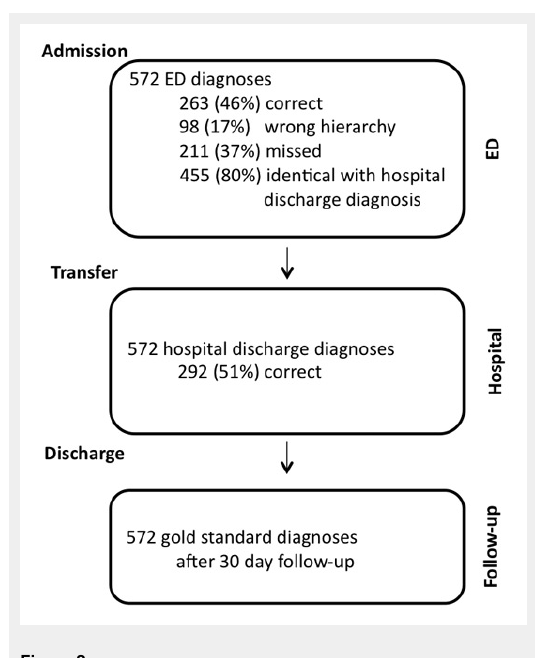
Overview of the proportions of correct diagnoses . Gold standard diagnosis: Final diagnosis, according to rules of the 10th International Classification of Diseases and Related Health Problems (ICD-10), made independently by two physicians as